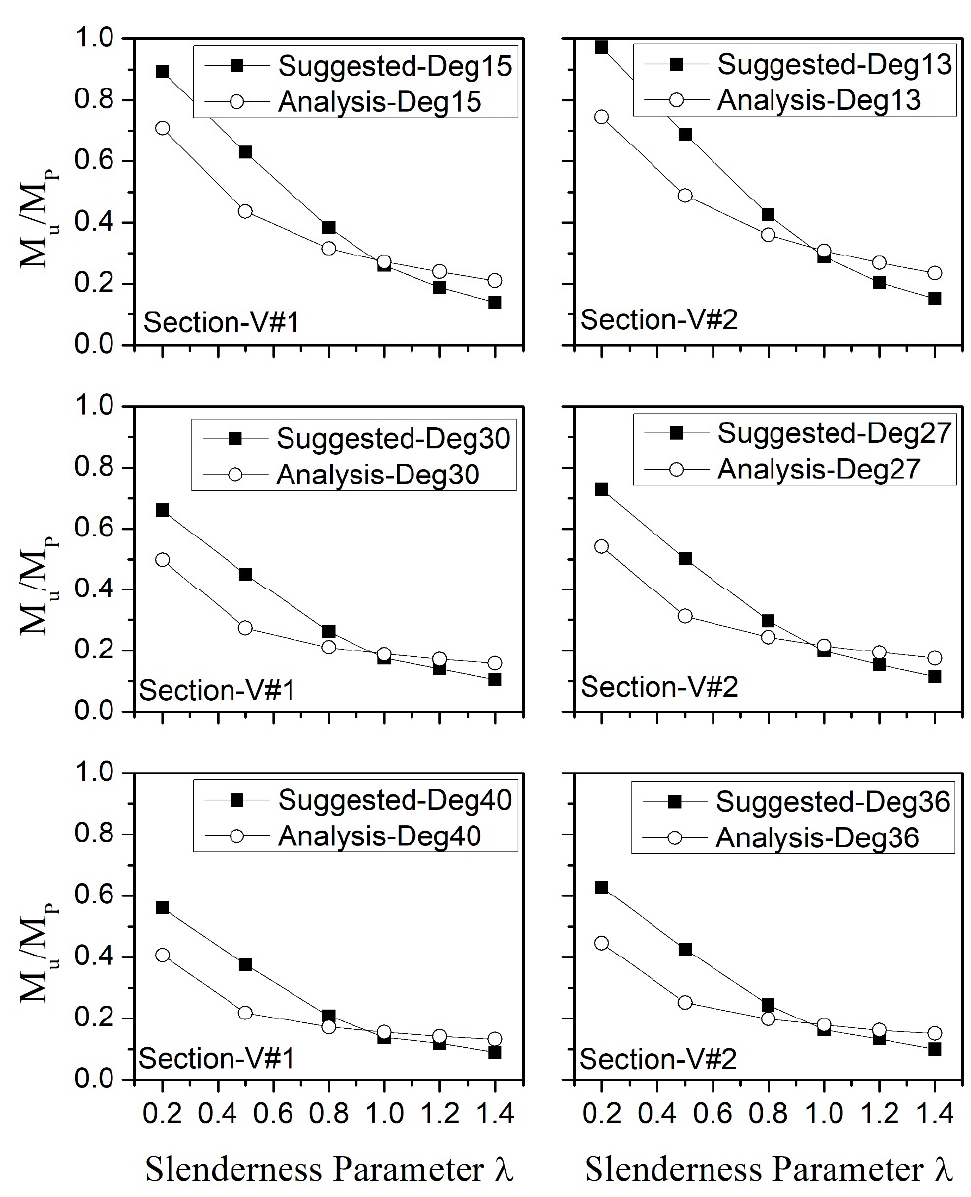
Figure 11. Verification Analysis.